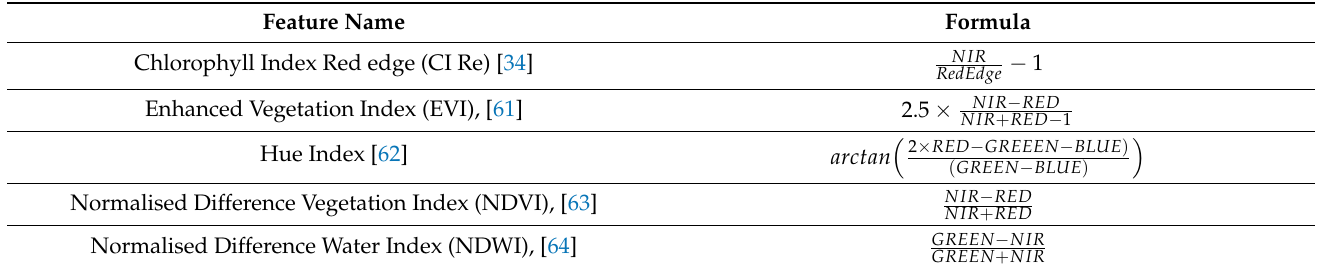
Table 3. List of derivative features selected and used in the classification dataset.